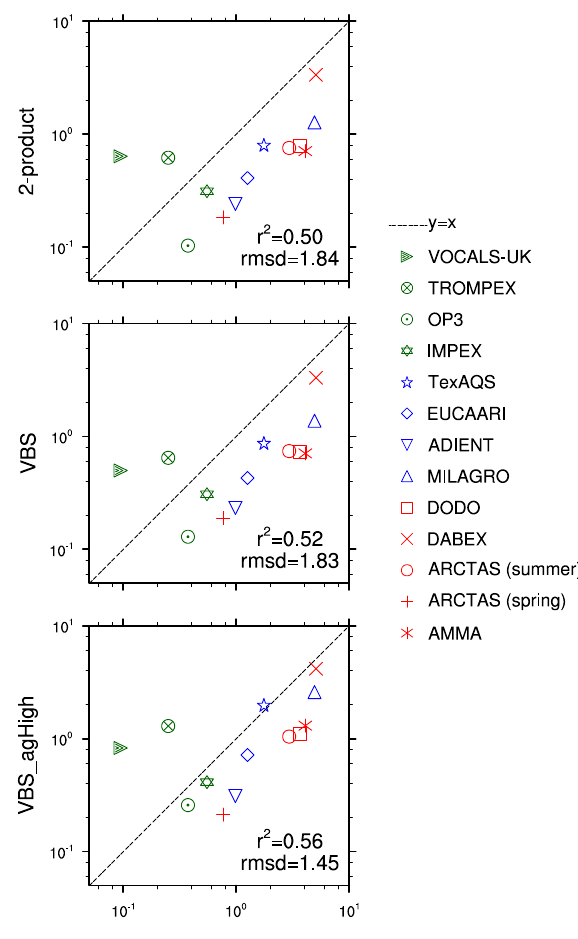
Figure 5. Comparison between averaged OA concentration (µgm − 3 ) from 13 AMS field campaigns and the three model sim- ulations: 2-product, VBS and VBS_agHigh. The campaign infor- mation is summarized in Heald et al. (2011) (Fig. 1 and Table 1 therein). All data in each campaign are temporally, horizontally and vertically averaged to a single value and compared to the model outputs averaged over the same period and